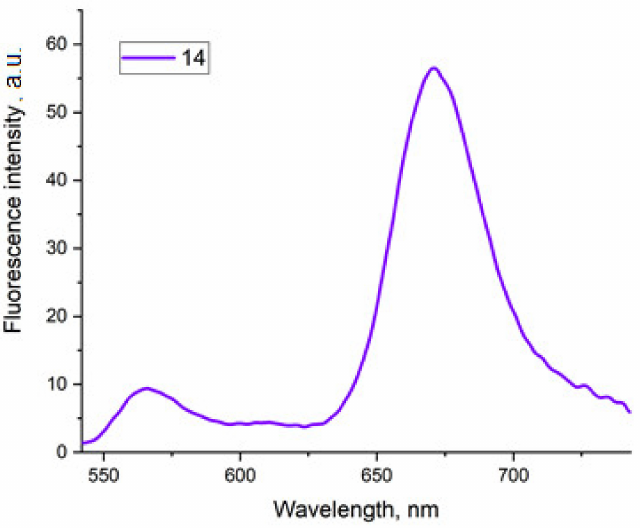
Figure 4. Fluorescence spectrum of ADC 14 (emission spectrum, excitation wavelength: 520